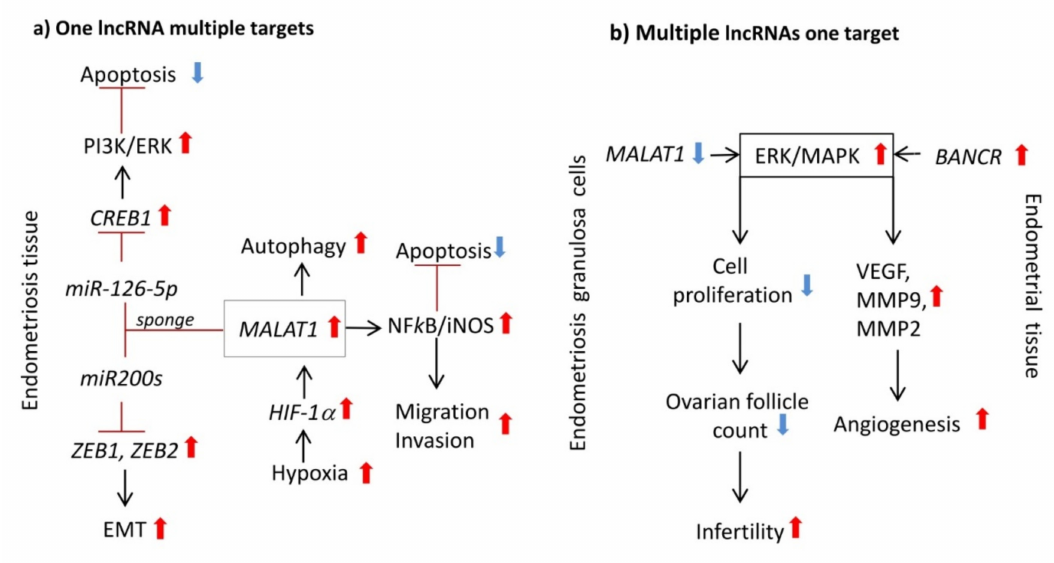
Figure 3. ( a ) MALAT1 was identified as a sponge of miR-200c . This regulation is not restricted to miR-200c and might include the entire miR-200 family ( miR-200s ), consisting of miR-200a , miR-200b , miR-200c , miR-141 , and miR-429 . Upregulation of MALAT1 in women with endometriosis leads to enhanced sponging of miR200s and promotes zinc finger E-box binding homeobox transcription factor 1 (ZEB1) and ZEB2 expression leading to higher EMT. In HESCs, the lncRNA MALAT1 directly interacts with miR-126-5p , which regulates cAMP responsive element-binding protein (CREB1) expression. Upregulation of MALAT1 inhibits apoptosis probably via activation of the PI3K–AKT pathway through the miR-126-5p –CREB1 axis. MALAT1 lncRNA can also lead to reduced apoptosis in HESCs through the upregulation of the NFkB/iNOS signaling pathway activity, which also enhances migration and invasion of cells. In cultured primary endometrial stromal cells, MALAT1 leads to upregulation of hypoxia-induced autophagy. In this signaling cascade, regulation of MALAT1 expression is under the control of the HIF1 α transcription factor. ( b ) In granulosa cells (GCs) of women with endometriosis, significant downregulation of MALAT1 expression was reported. MALAT1 knockdown induced an increase in phosphorylated ERK1/2 (p-ERK1/2) that was associated with altered follicle count, due to impaired cell proliferation resulting from ERK/MAPK- dependent activation of p21/p53 cell cycle arrest. In an autograft transplantation rat model of endometriosis, inhibition of the lncRNA BANCR led to a decrease in ectopic tissue volume associated with a significant reduction in serum levels of VEGF , MMP-2 , and MMP-9, ERK , and MAPK mRNA and in phosphorylated ERK and MAPK protein levels in tissues. HESCs: human endometrial stromal